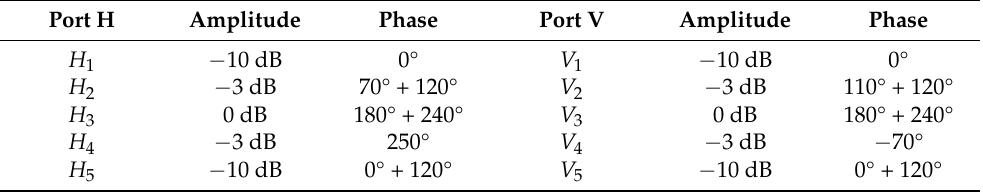
Table 7. Amplitude and phase values. Beamforming. Array with sequential 90°